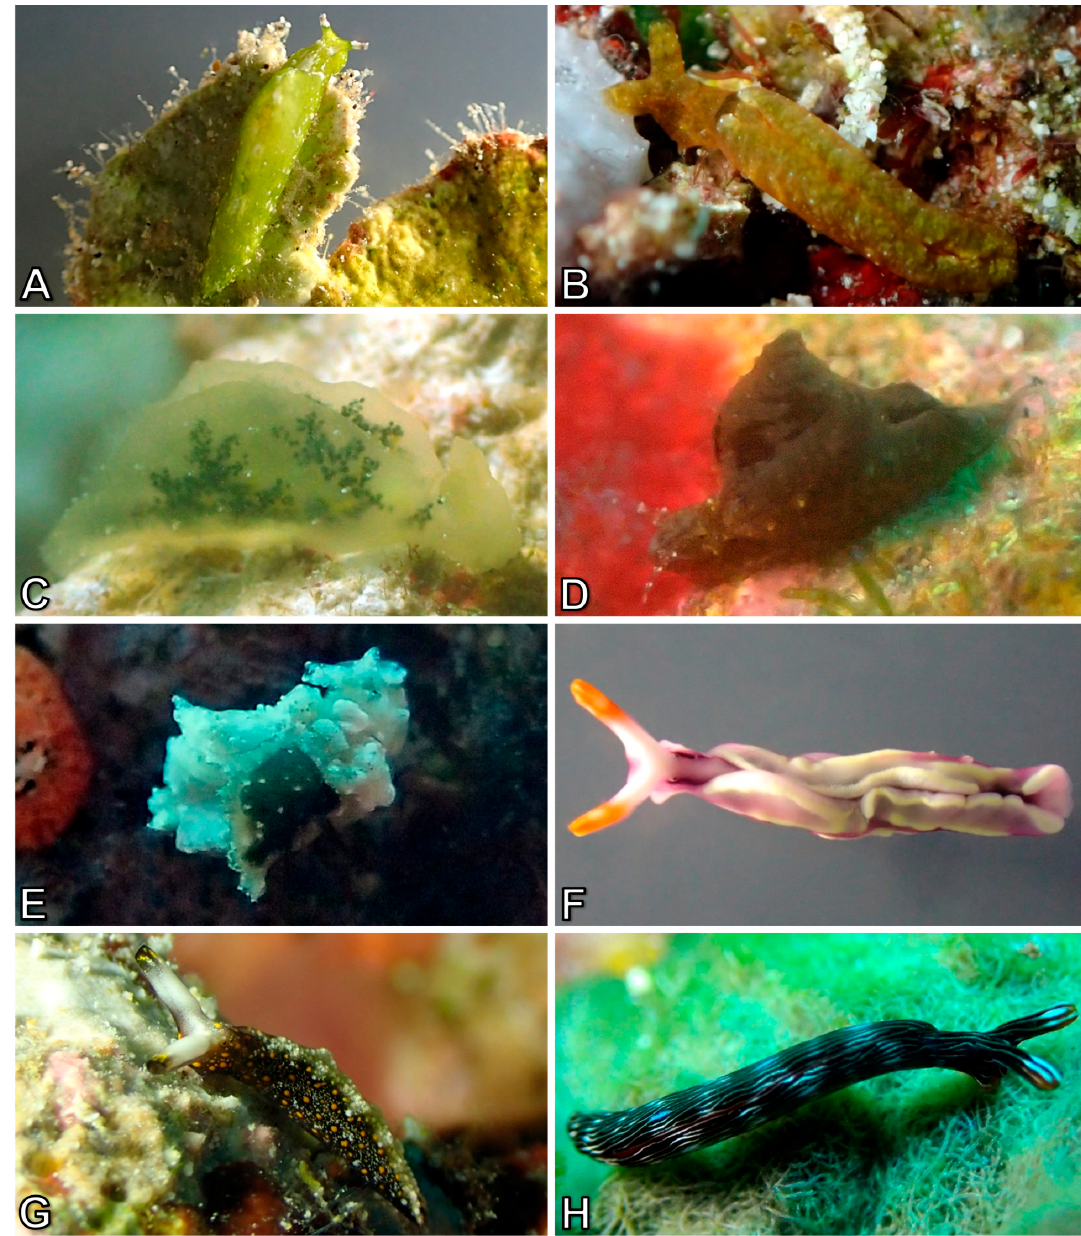
Figure 5. Sacoglossa: ( A ) Elysia pusilla ; ( B ) Elysia spec. ( Elysia sp. 25 in Gosliner et al. [11]: 89), Elsp30_16Bu-3; ( C ) Elysia spec., Elsp1_16Bu-1; ( D ) Elysia spec., Elsp16Bu-1; ( E ) Elysia spec., Elsp16Bu-1; ( F ) Thuridilla albopustulosa ; ( G ) Thuridilla flavomaculata ; ( H ) Thuridilla gracilis.